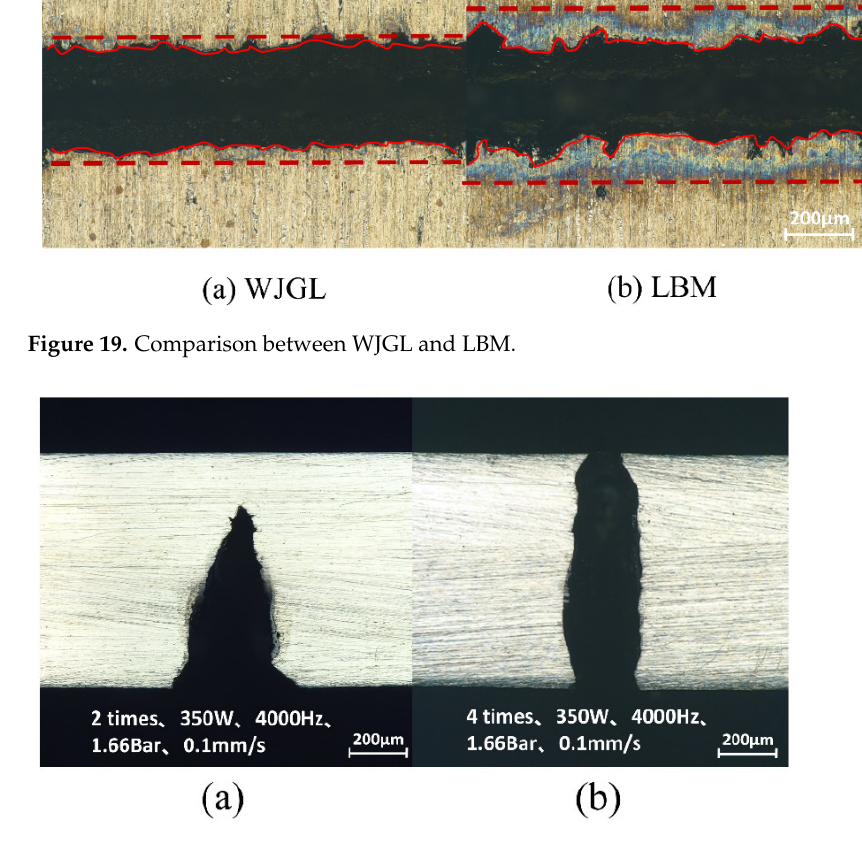
Figure 20. Cutting effect with different cutting toolpath times after optimization.